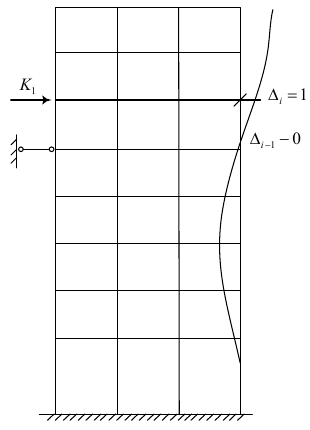
Figure 2: The calculation model of lateral rigidity in the th i